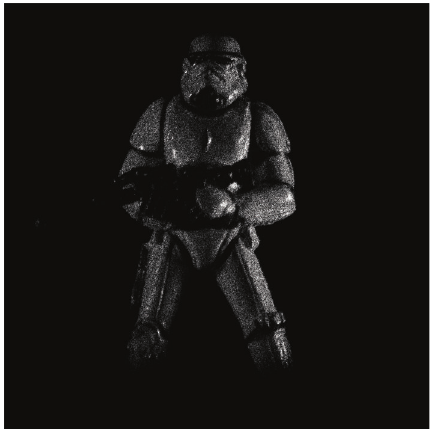
Figure 7: This reconstruction is the same as Figure 5, where both the conjugate image term and the DC terms have been removed. Unlike in the numerical procedure used in Figure 5, we have applied a PSI technique to separate out the real image